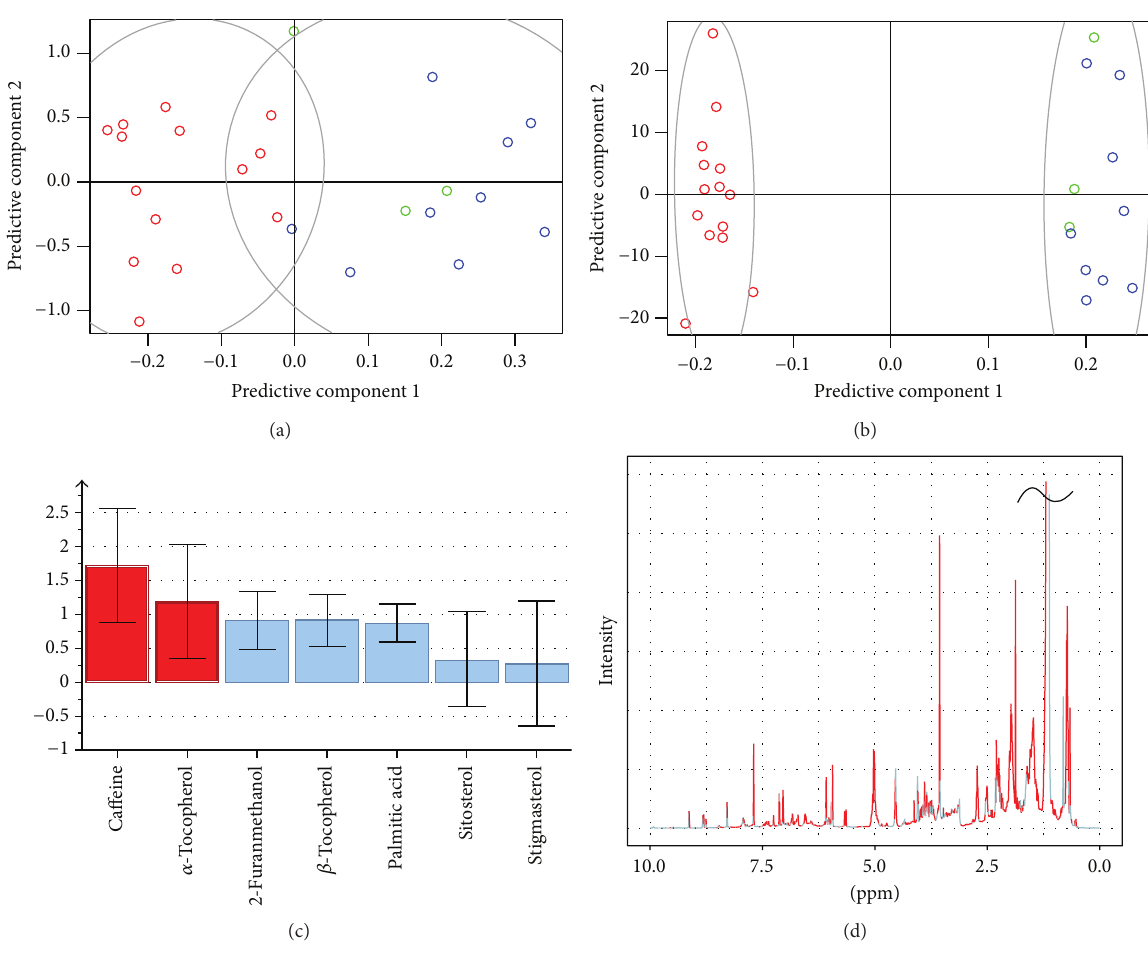
Figure 2: Score plots of PLS-DA for classification by country of origin (Colombia versus Others) performed with GC-MS (2 LVs, (a)) and 1 H-NMR (8 LVs, (b)). Red, green, and blue open circles are for Colombia, Peru, and Brazil, respectively. (c) VIP plots obtained for GC-MS model. (d) NMR spectra colored according to the results of VIP analysis. The red color (VIP > 1) means that the variable contributes to prediction, while the light blue color (VIP < 1) is for predictors that do not contribute. VIP scores obtained from NMR show that most of the spectra (peaks) are contributing to the classification, highlighting that a large number of observable compounds are important for the determination of origin of coffee beans. A total of 662 predictors were found with VIP >